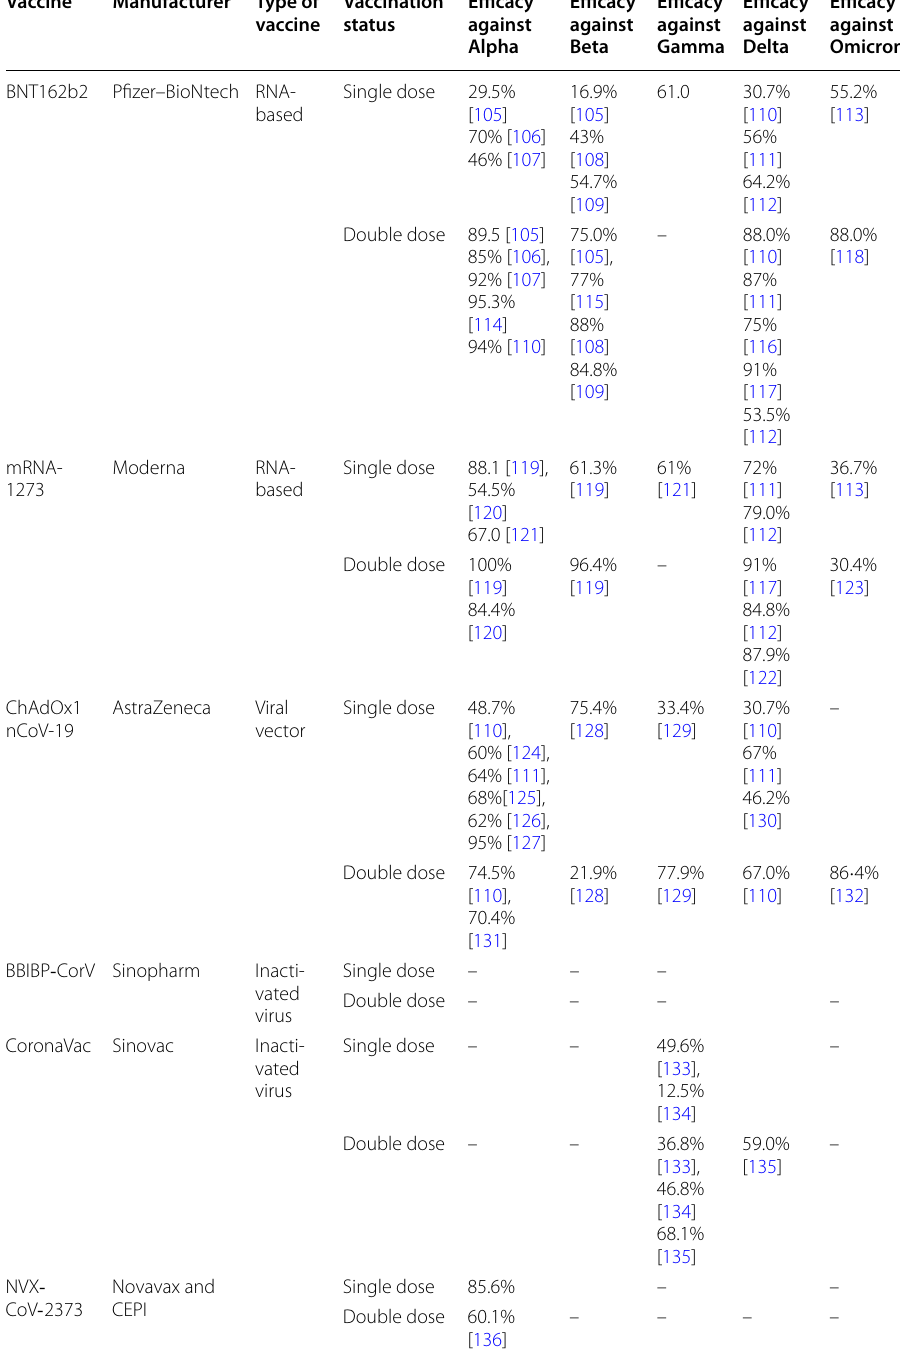
Table 1 The efficacy of vaccines against SARS‑CoV‑2 variants of concern Vaccine Manufacturer Type of